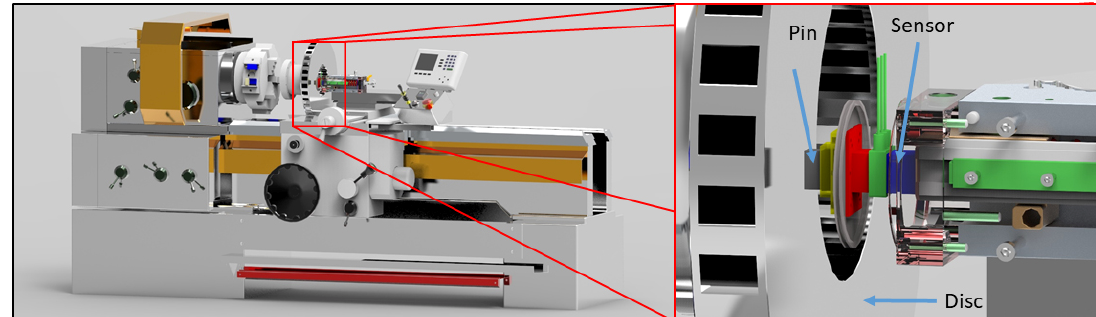
Fig. 2 Scheme of the tribometer used. Reproduced with permission from Ref. [13], © the authors 2018.